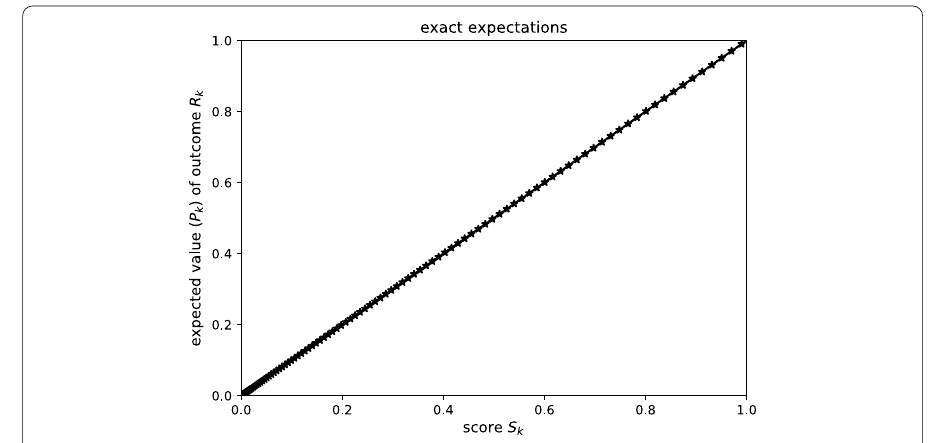
Fig. 51 Ground-truth reliability diagram for Fig.